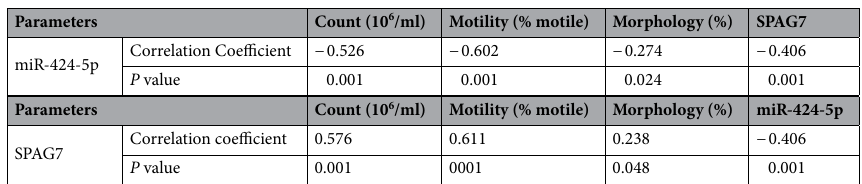
Table 2. Correlation analysis between the expression level of miRNAs, SPAG7, and basic semen parameters. Spearman correlation analysis. An Unpaired two-tailed t-test was used to calculate the P -values. P < 0.05 was considered statistically